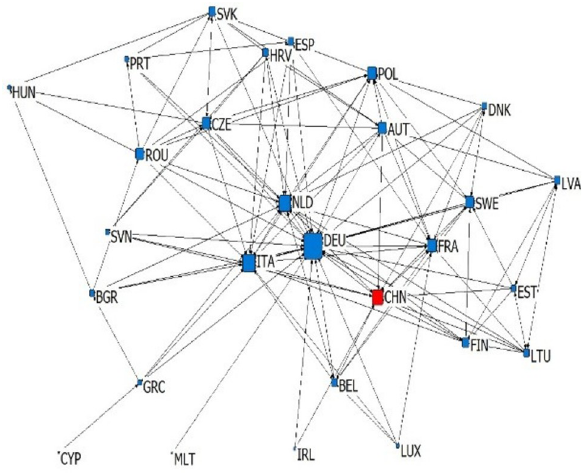
Fig 6. Horizontal intra industry import dependence